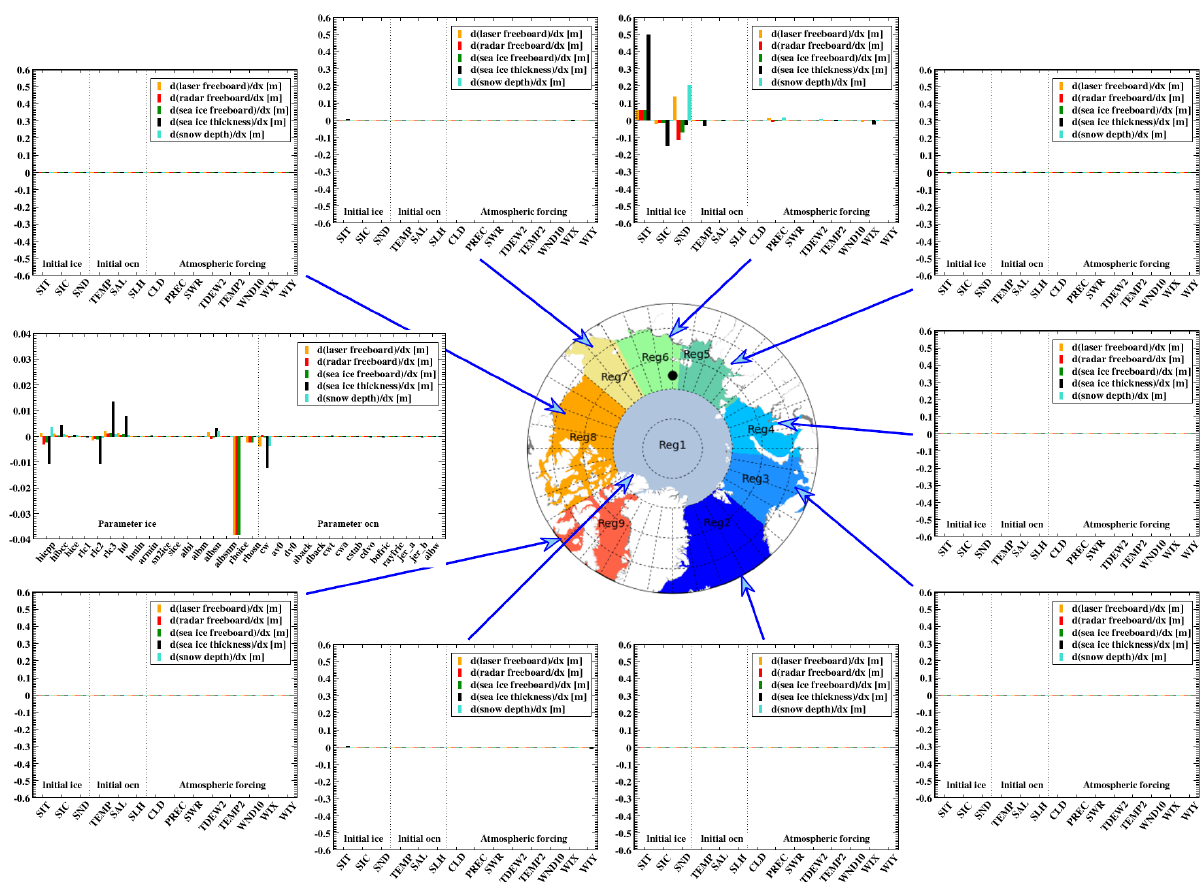
Figure 14. The sensitivities of the respective EO product to the control vector (observational Jacobians) for April means of LFB (orange bars), RFB (red bars), SIFB (green bars), SIT (black bars), and SND (cyan bars) over a single point indicated by the black dot (and by black cross on Fig. 3). The observational Jacobians with respect to the process parameters are shown in the left middle panel. The other panels show the observational Jacobians with respect to the initial and forcing fields for each control region (see Table 1 for an explanation of the